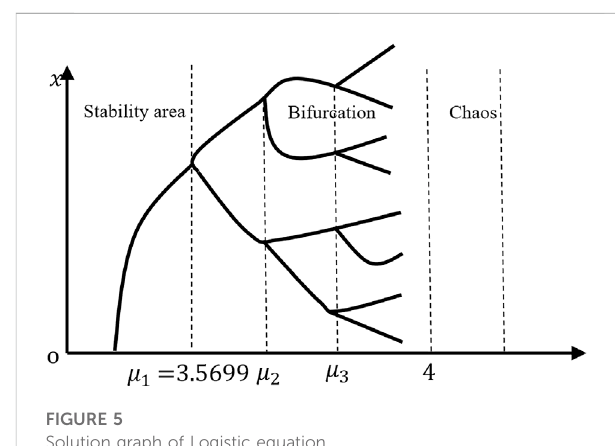
FIGURE 5 Solution graph of Logistic equation.